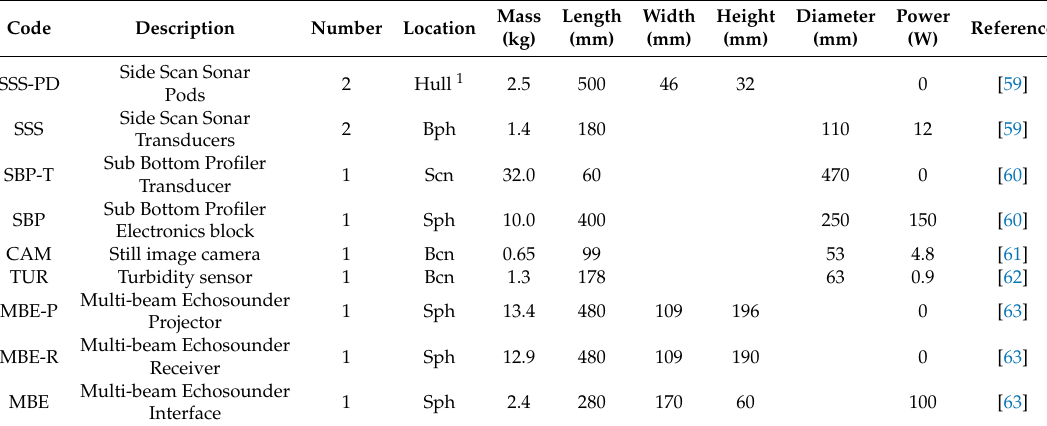
Table A1. Payload characteristics. Bph, bow pressure hull. Cph, central pressure hull. Sph, stern pressure hull. Bcn, bow cone. Scn, stern cone. Hull, attached to the external hull.